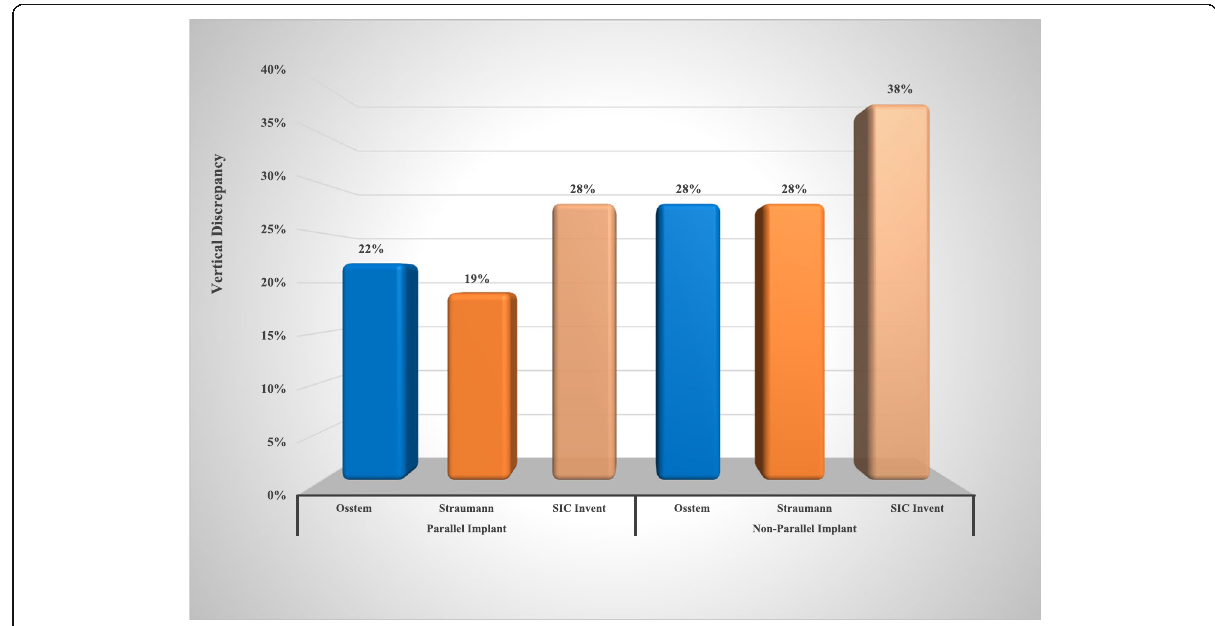
Fig. 6 Effect of implant angulation on the vertical discrepancy of all implant